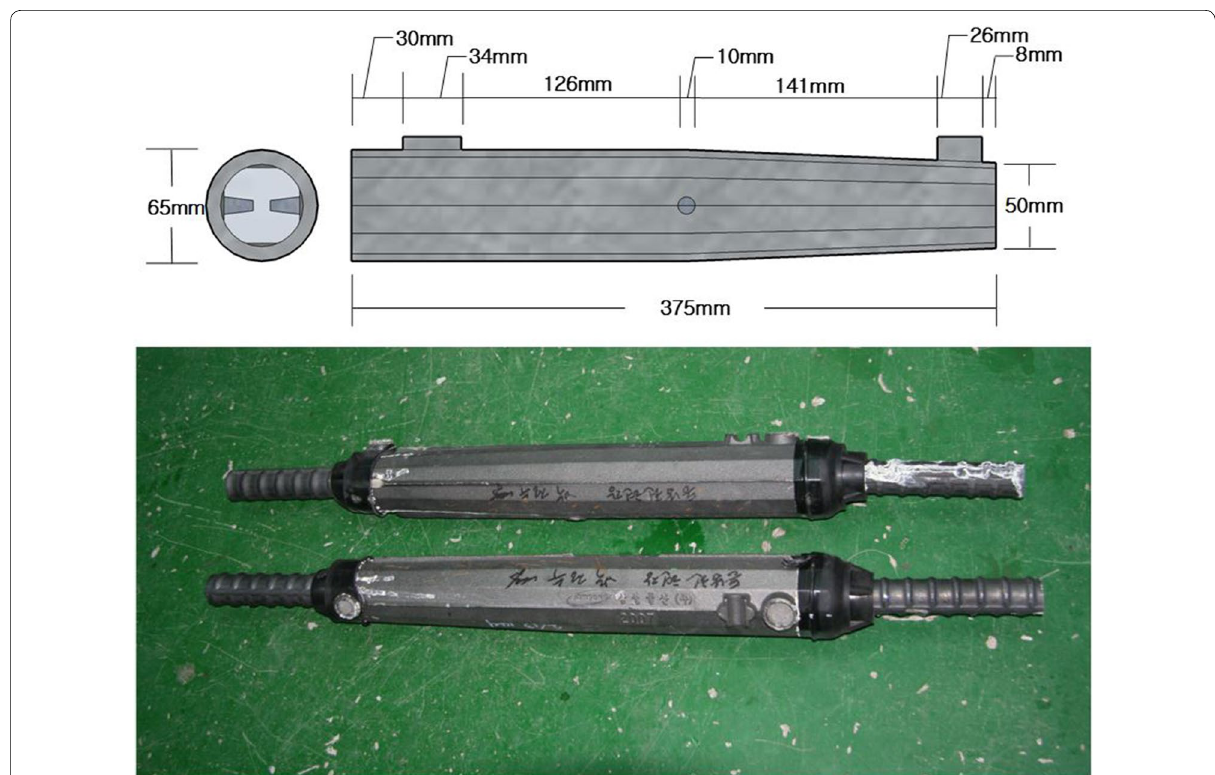
Fig. 2 Splice sleeve.